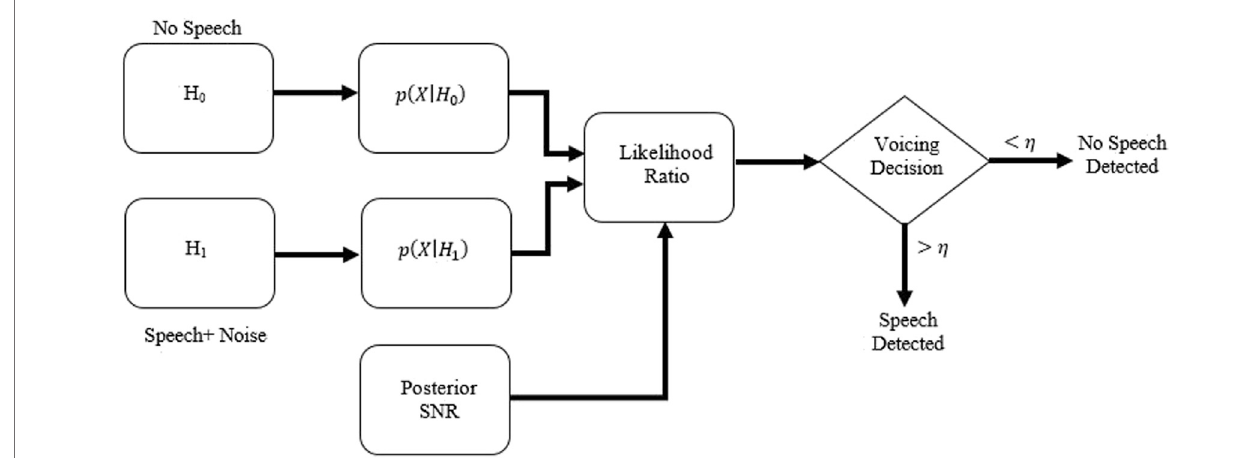
FIGURE 2 | Diagram of using VAD for speech Bishop, 2006.